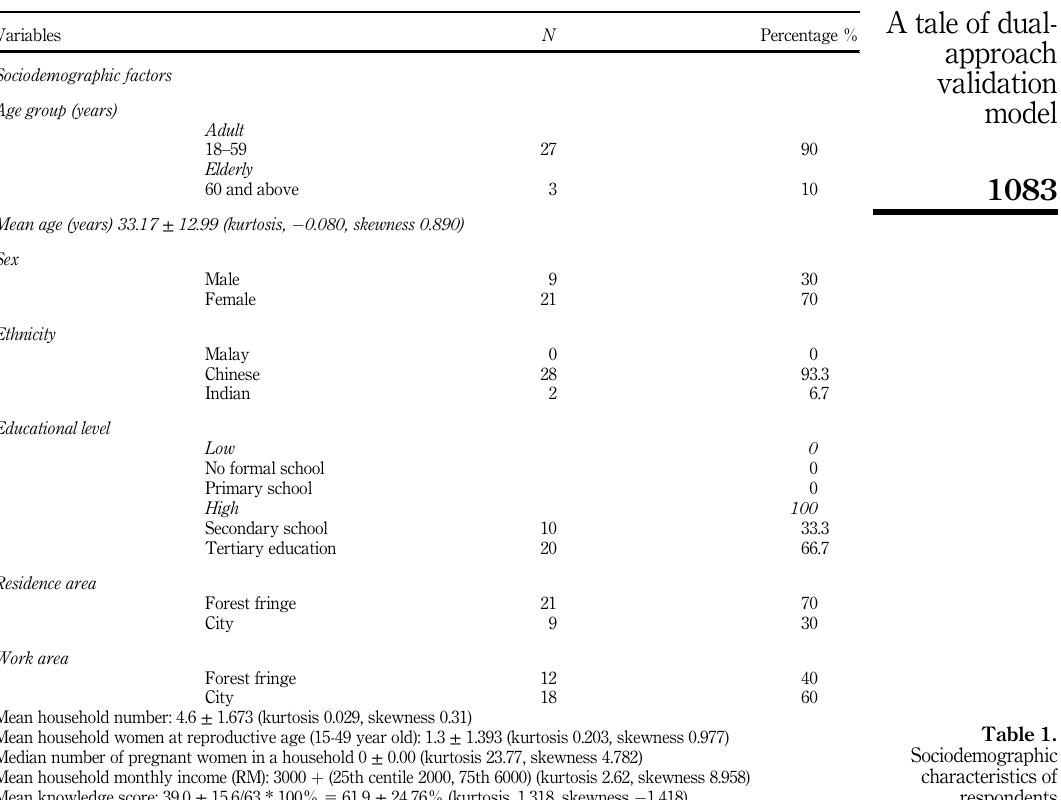
characteristics of